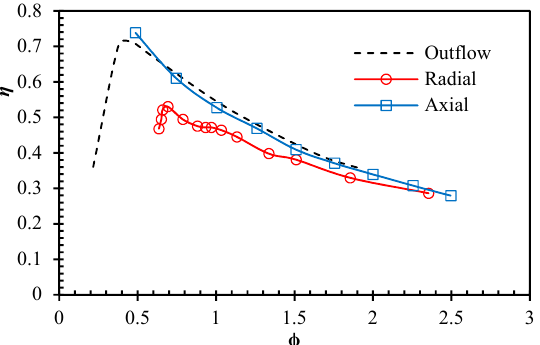
Figure 25. Comparison of the efficiency (total to static) of the optimum outflow turbine with the existing radial [22] and axial turbines [16]. (Vertical axis: turbine efficiency, Horizontal axis: flow coefficient).